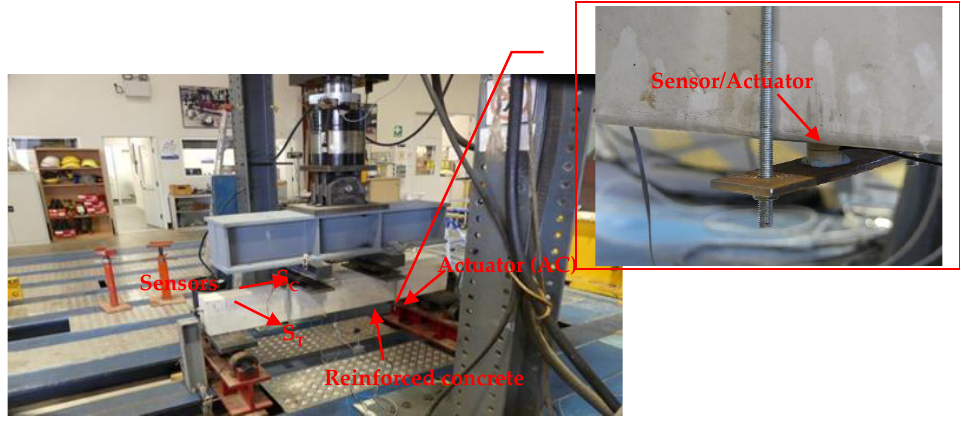
Figure 6. Reinforced concrete under four-point bending, Center of Infrastructure Engineering (CIE), Western Sydney University.